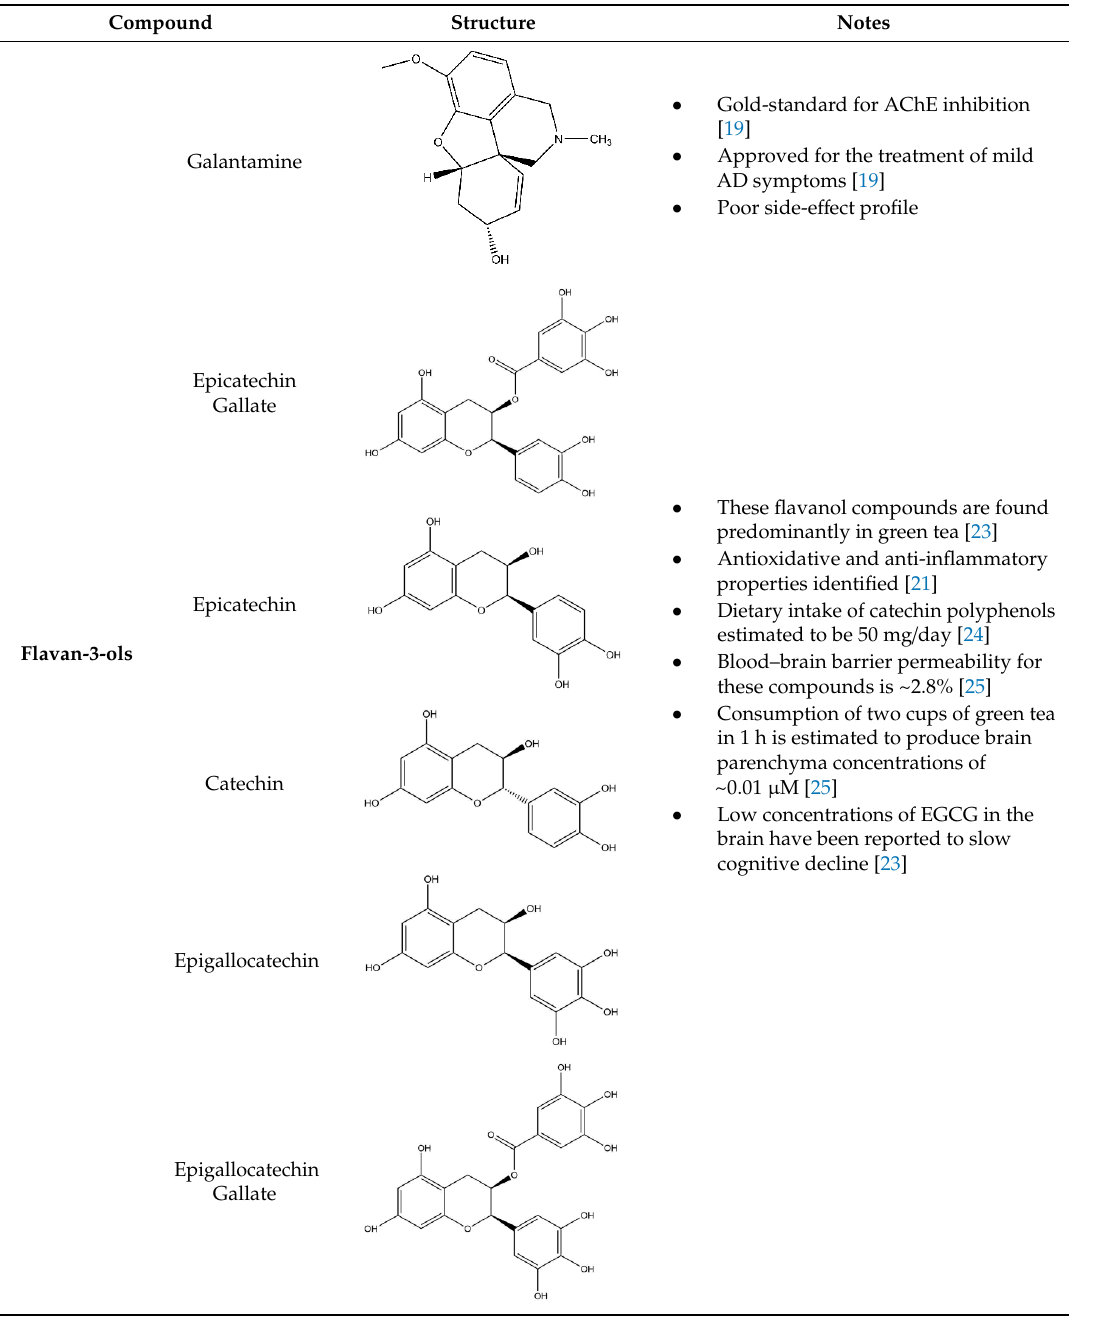
Table 1. Compound summary table: an overview of the chemicals assessed in this study with structures and notes for each shown. Chemical structures were produced using ChemDraw TM .